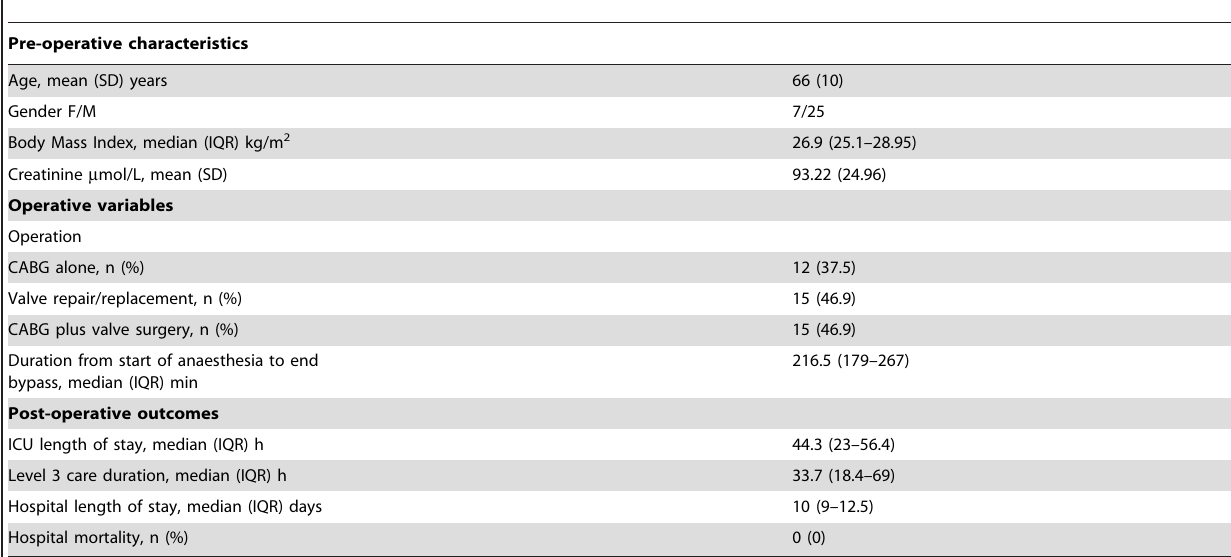
Table 1. Clinical and biochemical characteristics, operative variables and post-operative outcomes of study patients a .